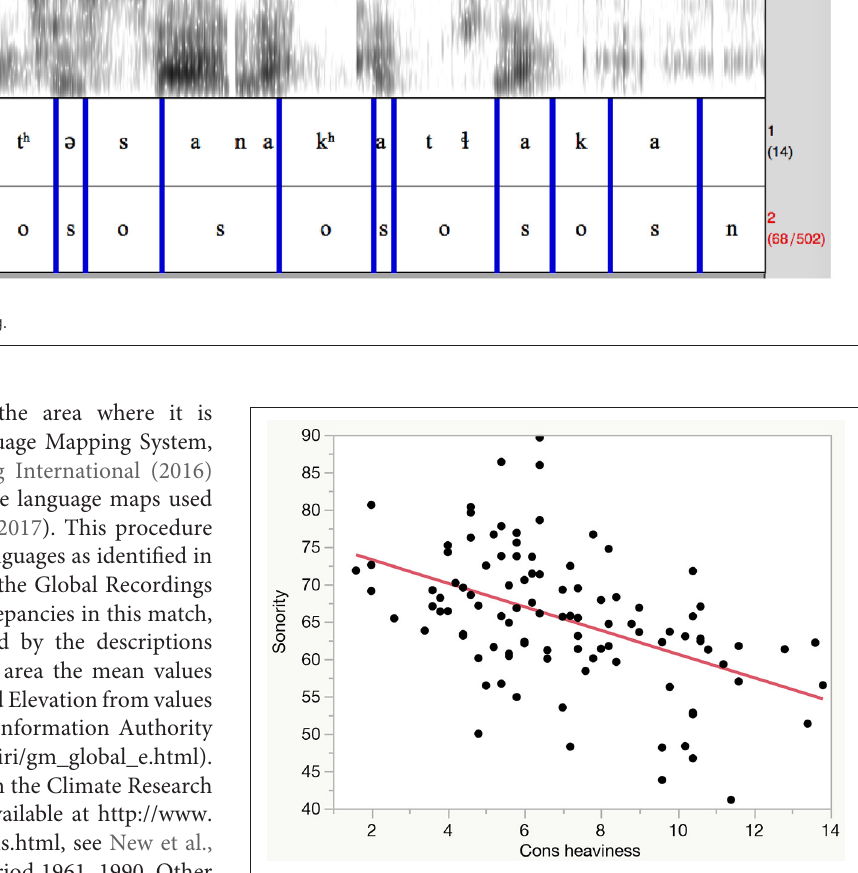
FIGURE 2 | Plot of “consonant heaviness” vs. sonority score for 103